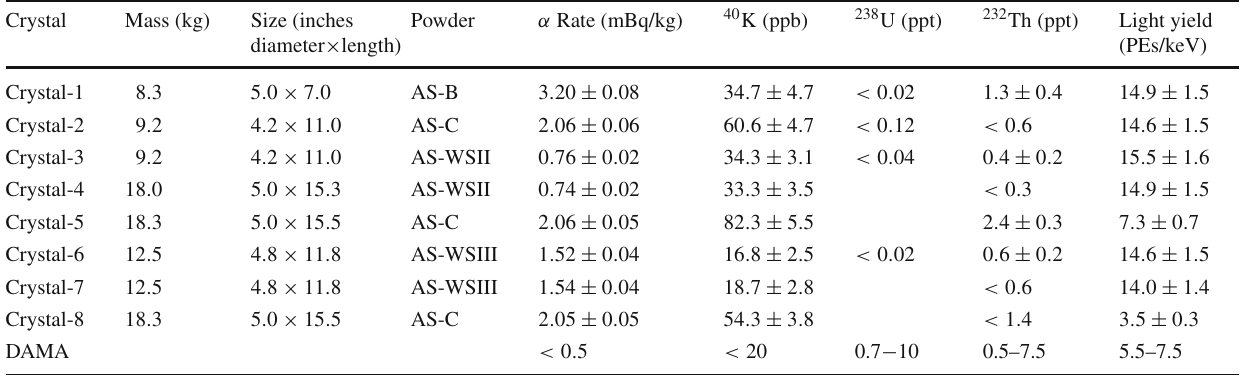
Table 1 Measured radioactivity levels in the COSINE-100 crystals. Thelightyieldismeasuredat59.6keVwitha 241 Amsourceandchecked for consistency with the 46.5keV internal 210 Pb γ -ray peak. The units Crystal Mass